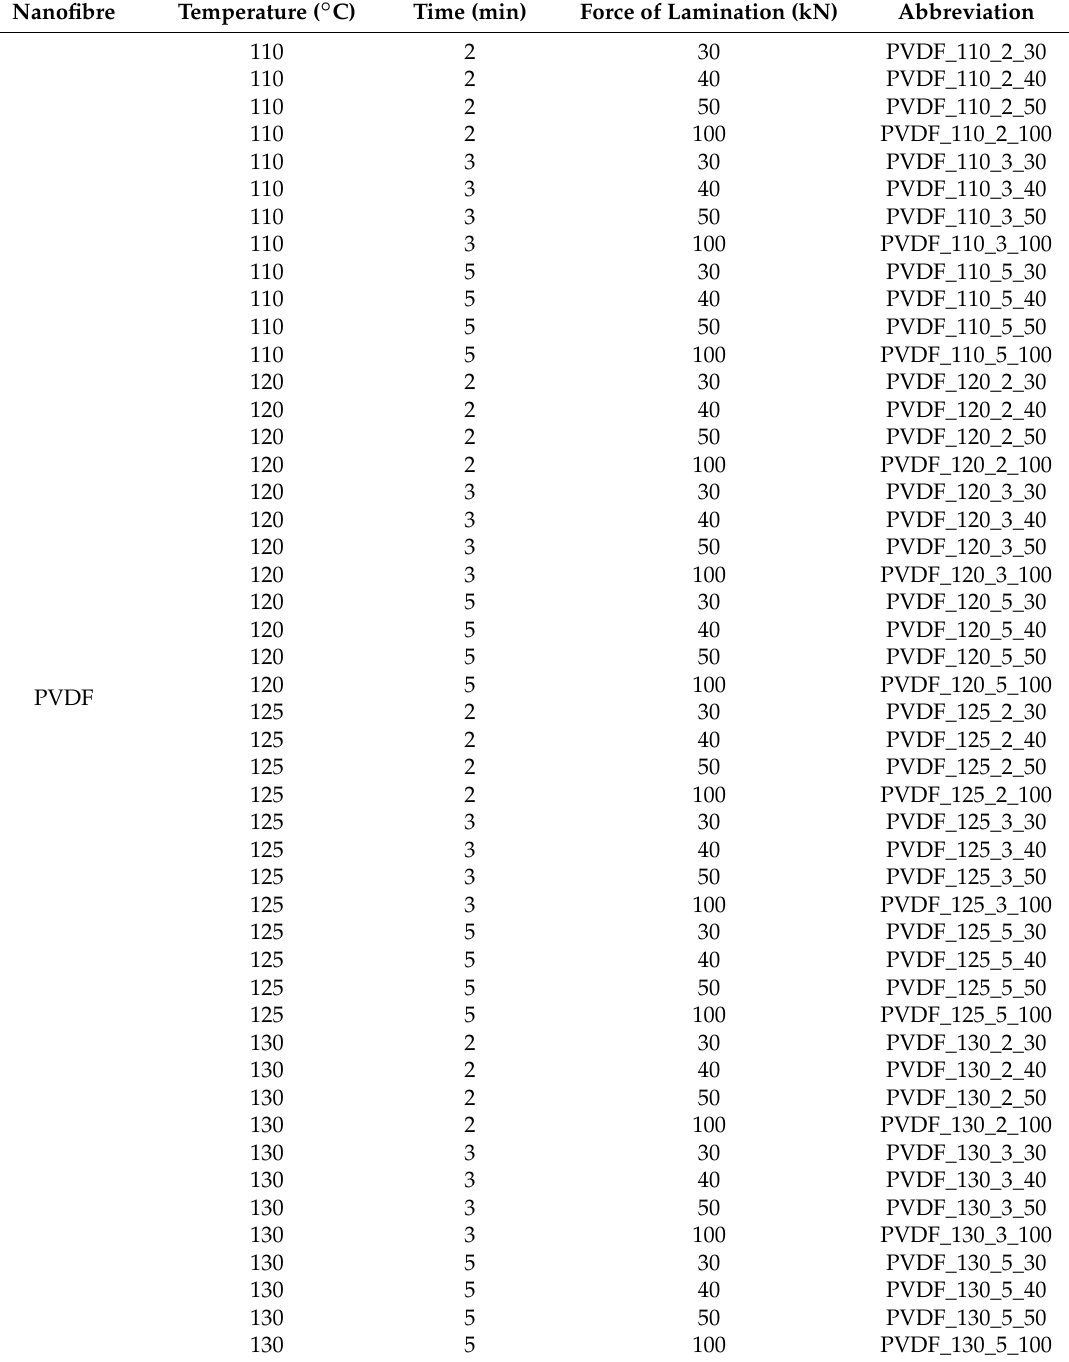
Table A1. Lamination condition and the abbreviation of the